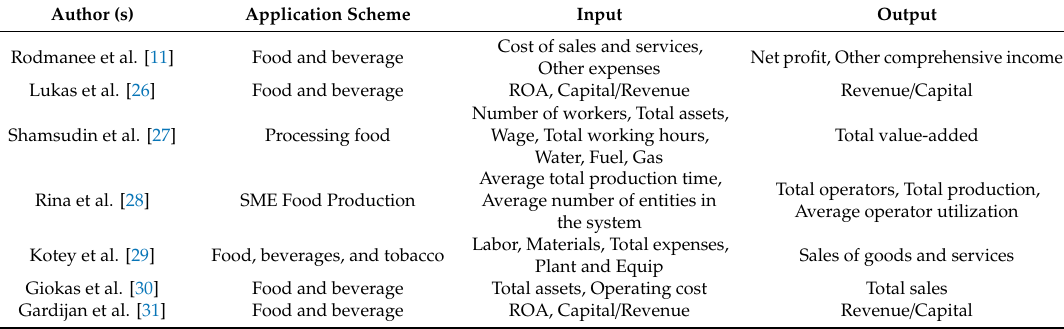
Table 2. List of some studies using the data envelopment analysis (DEA) method to evaluate the company’s e ffi